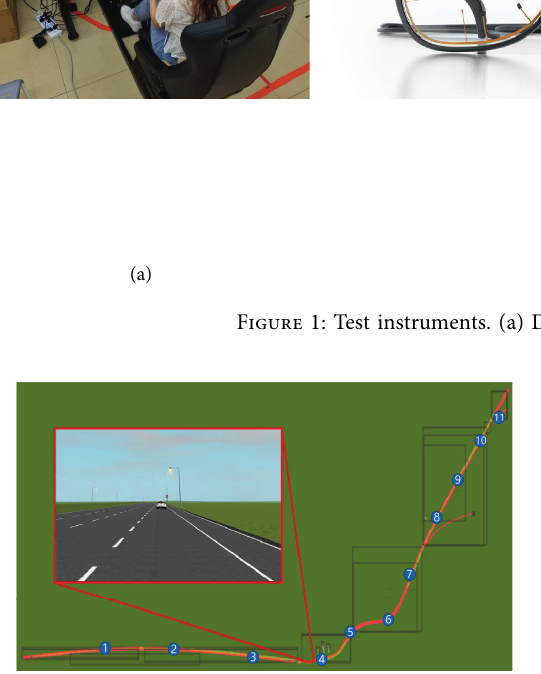
Figure 2: Test scenario.